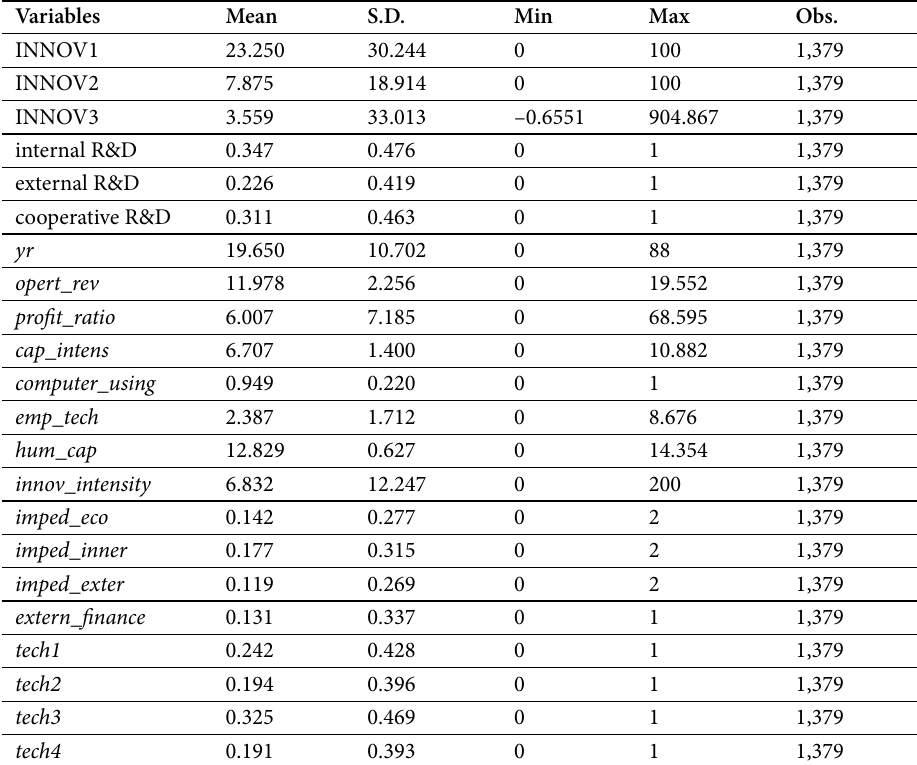
Table A-1. Summary